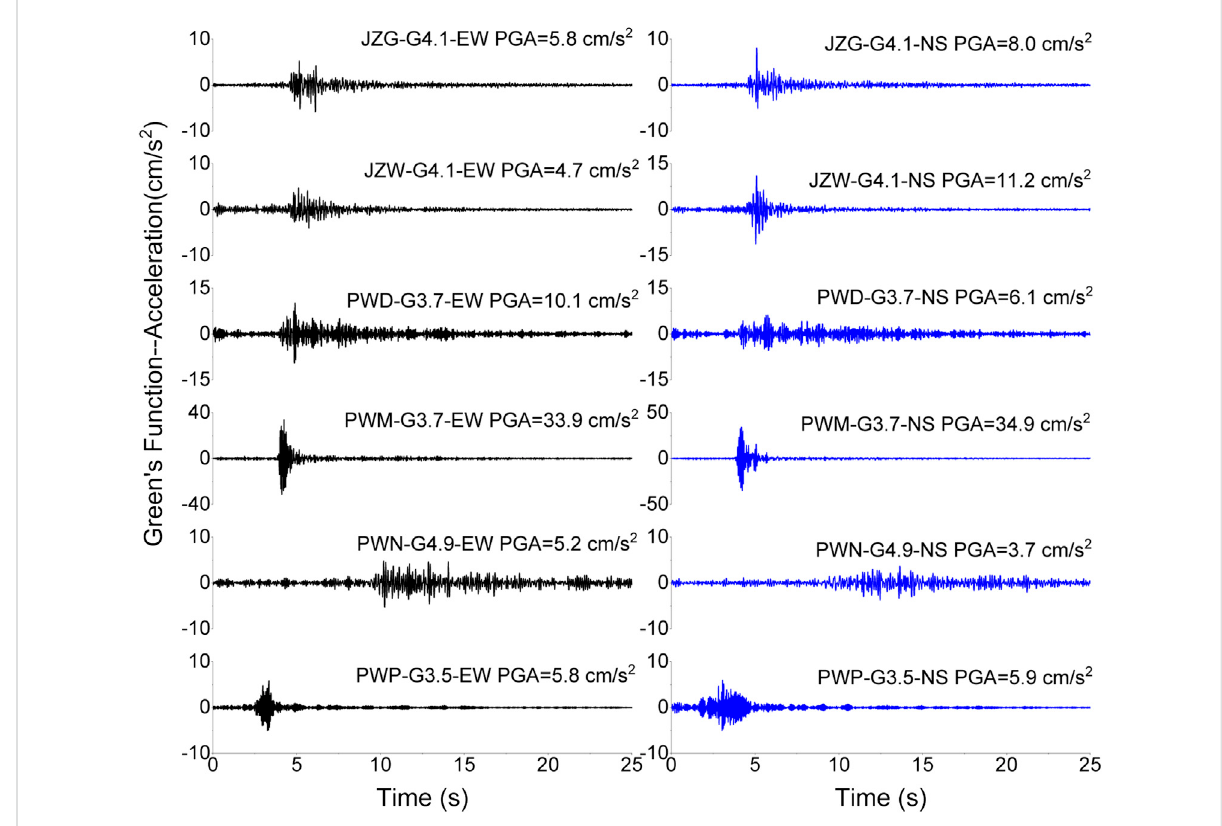
FIGURE 5 Horizontal Green function waveform and PGA at typical